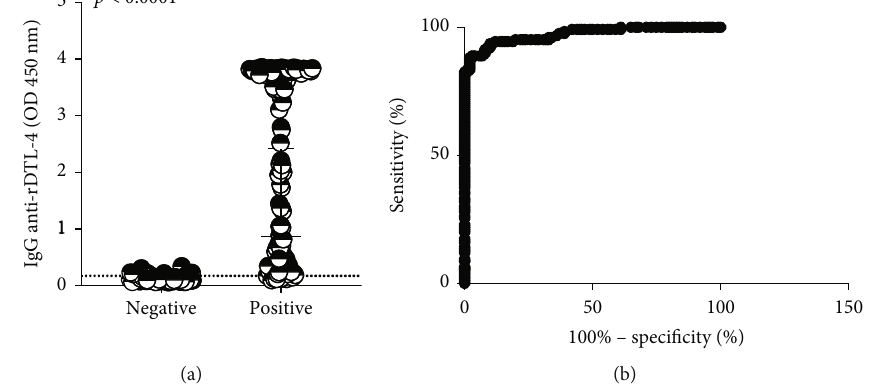
Figure 6: ELISA was performed to detect anti-DTL-4 IgG antibodies of sera. Sera from patients previously diagnosed with visceral leishmaniasis and healthy donors (panel 1.1). (a) DTL-4 discriminates signi fi cantly negative and positive samples ( p < 0 : 0001 ; Mann – Whitney test). (b) ROC curve constructed from the absorbance values calculated for the 126 samples from patients with con fi rmed VL and 100 samples from healthy controls from the endemic area. Cut − off = 0 : 173 . Area under thecurve = 0 : 9727